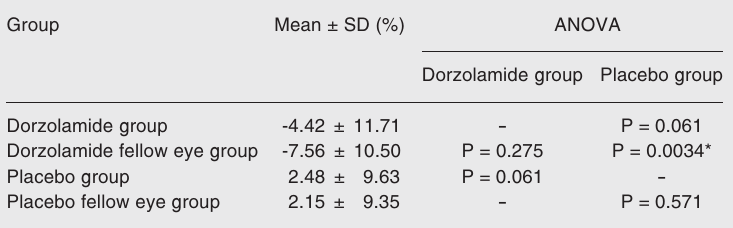
Table 1. Percent pachymetric variation in the eyes of the groups studied over a period of 18